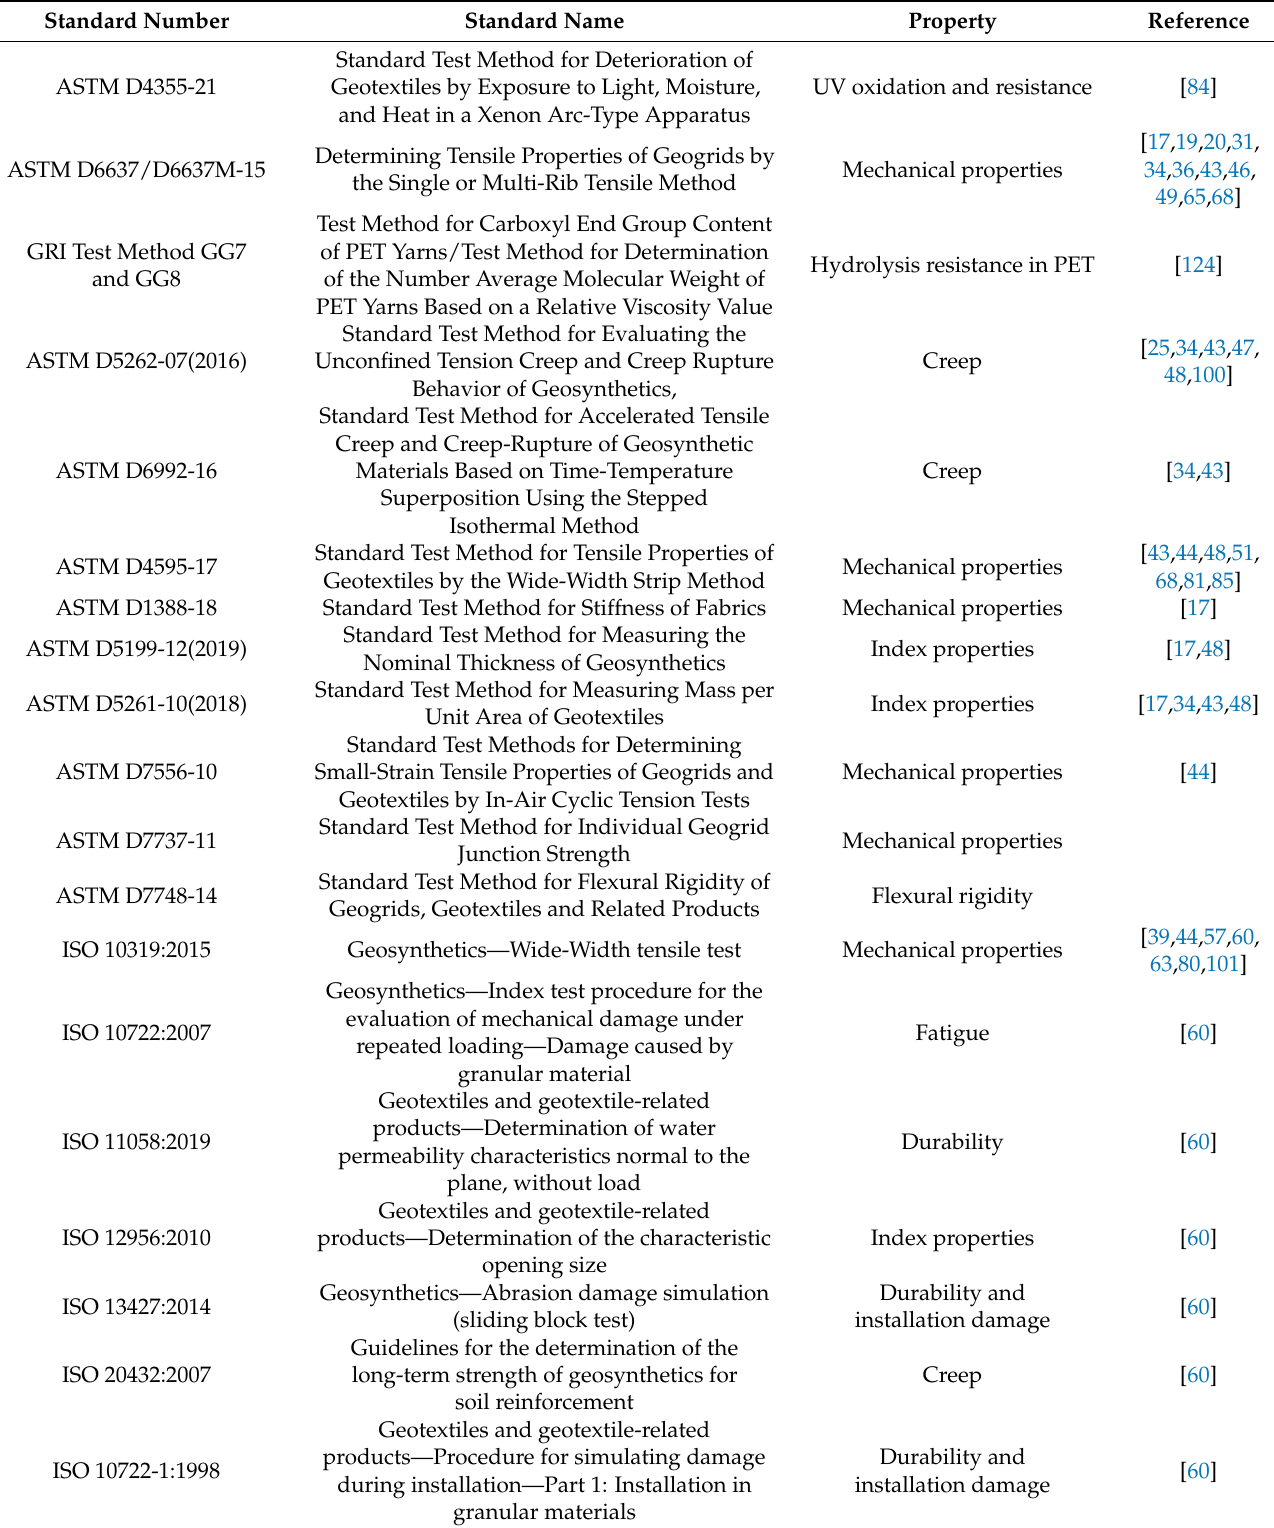
Table 3. Common test standards used to study the properties of the geogrid